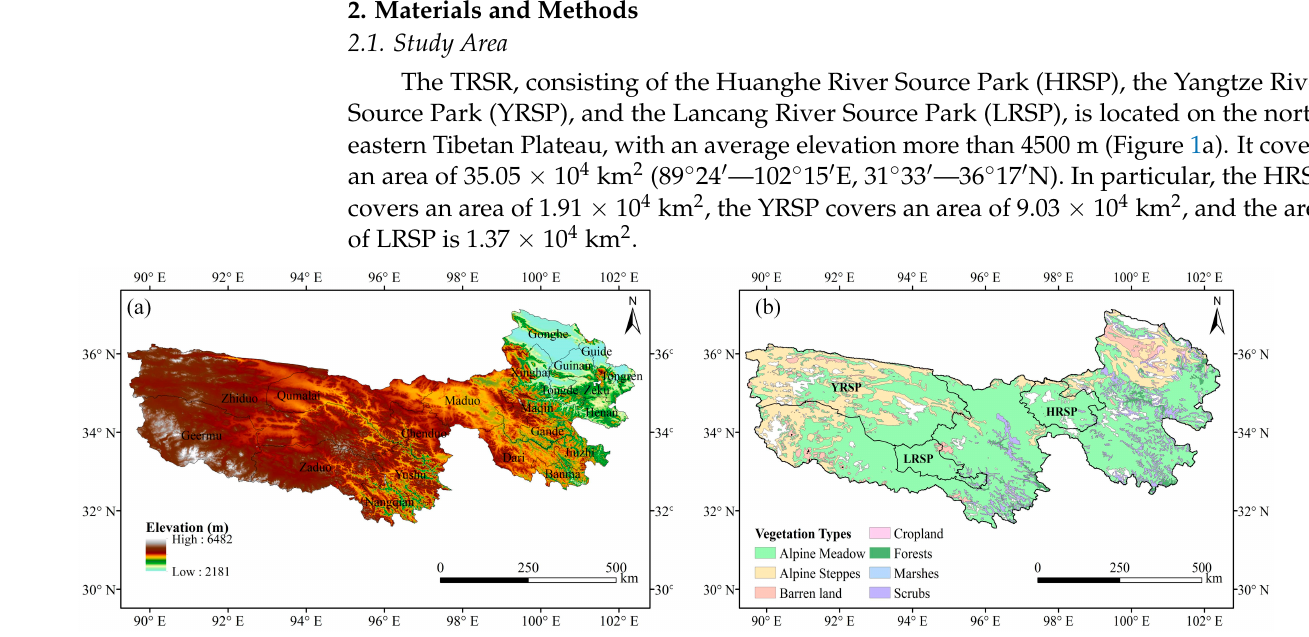
Table 1. Description of the data used in this